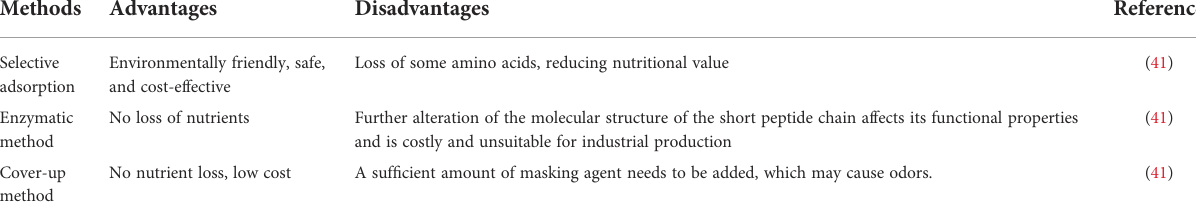
TABLE 4 Comparison of the advantages and disadvantages of the three methods of debittering.